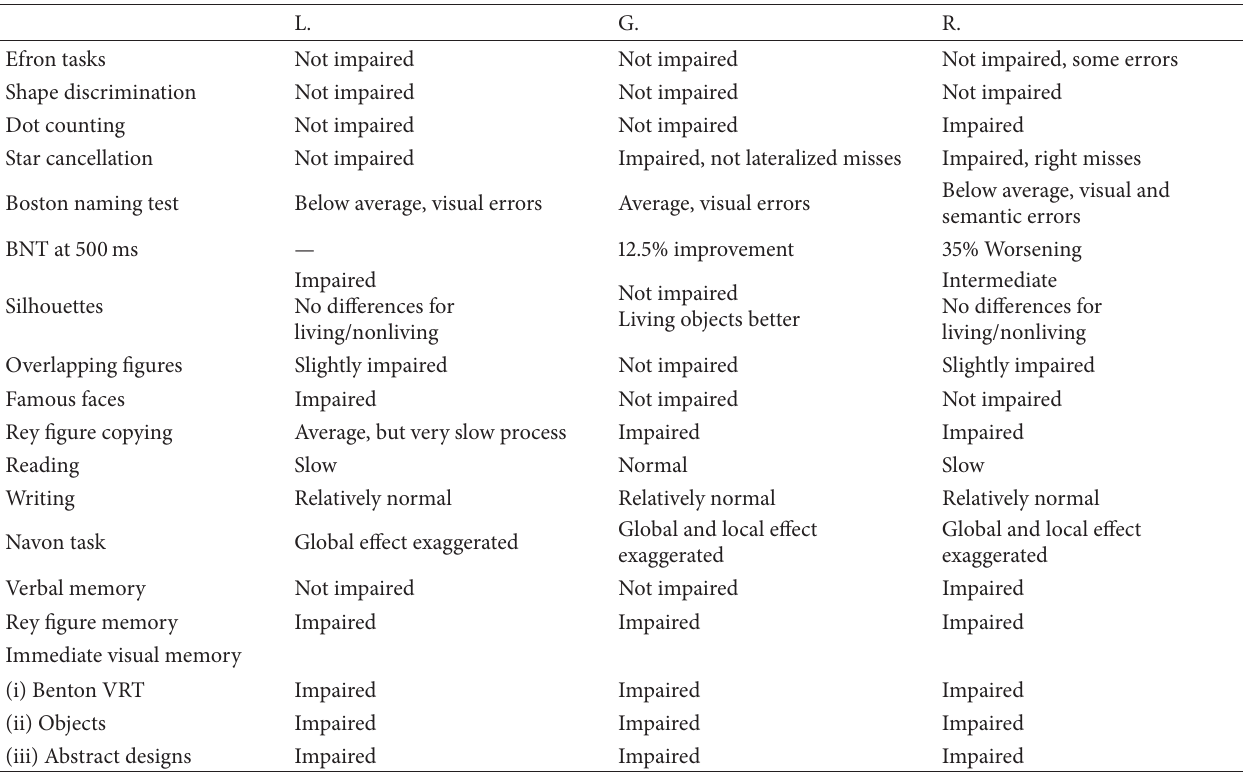
Table 3: Performance of each agnosic child on perception and memory tasks. L. G.